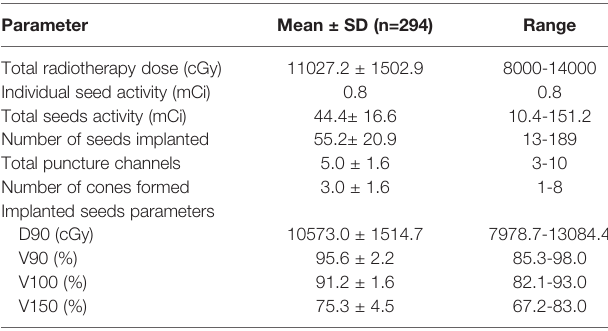
TABLE 3 | Overall I 125 seeds implantation parameters. Parameter Mean ± SD (n=294) Range Total radiotherapy dose